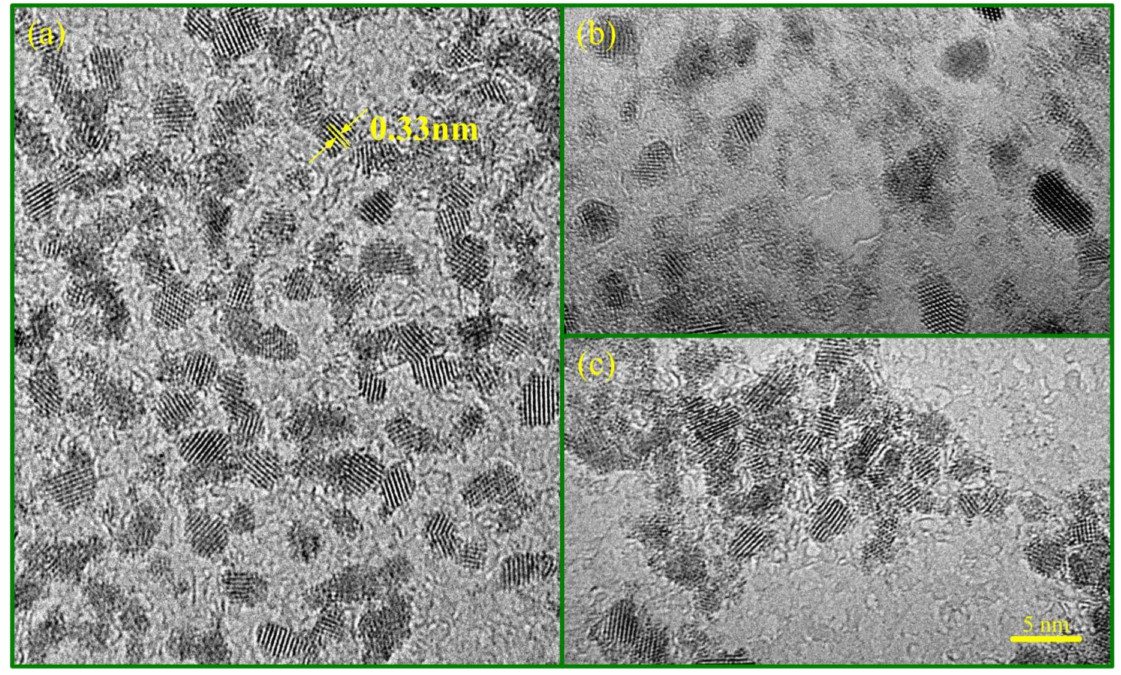
Figure 1. Transmission electron microscope morphologies of quantum dot (QD) samples: ( a ) QD0, ( b ) QD125, and ( c )